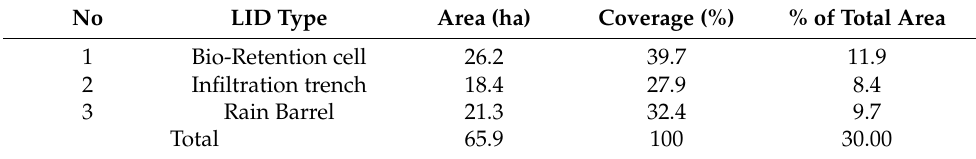
Table 4. Different land use types and areas within the study area.